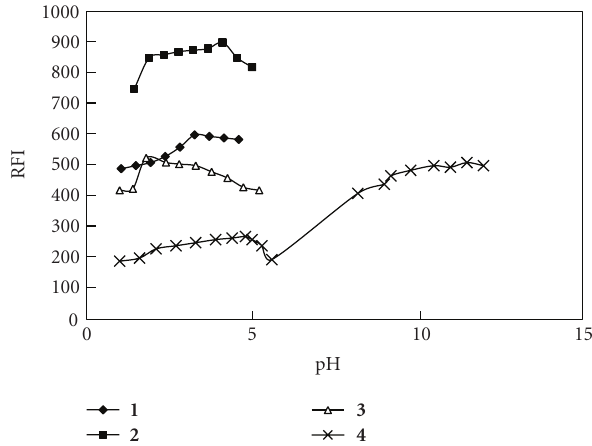
Figure 4: E ff ect of pH on fluorescence intensity of the reaction and reaction product of 1–4 with